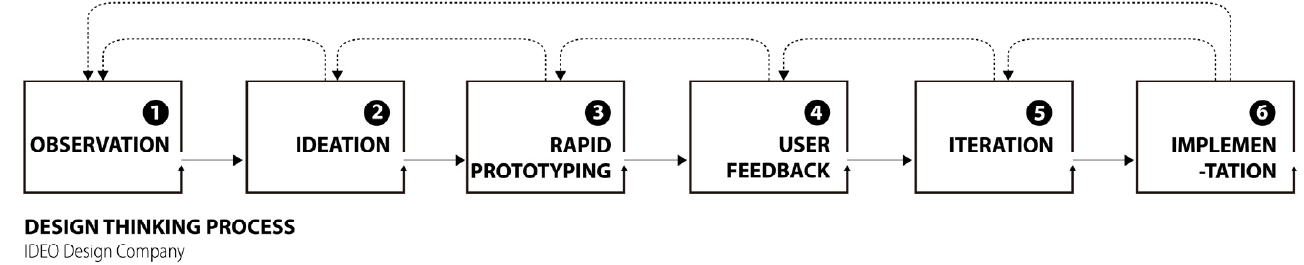
Figure 4. Design Thinking Process model of IDEO. (According to ref. [91], this figure is painted by this article).